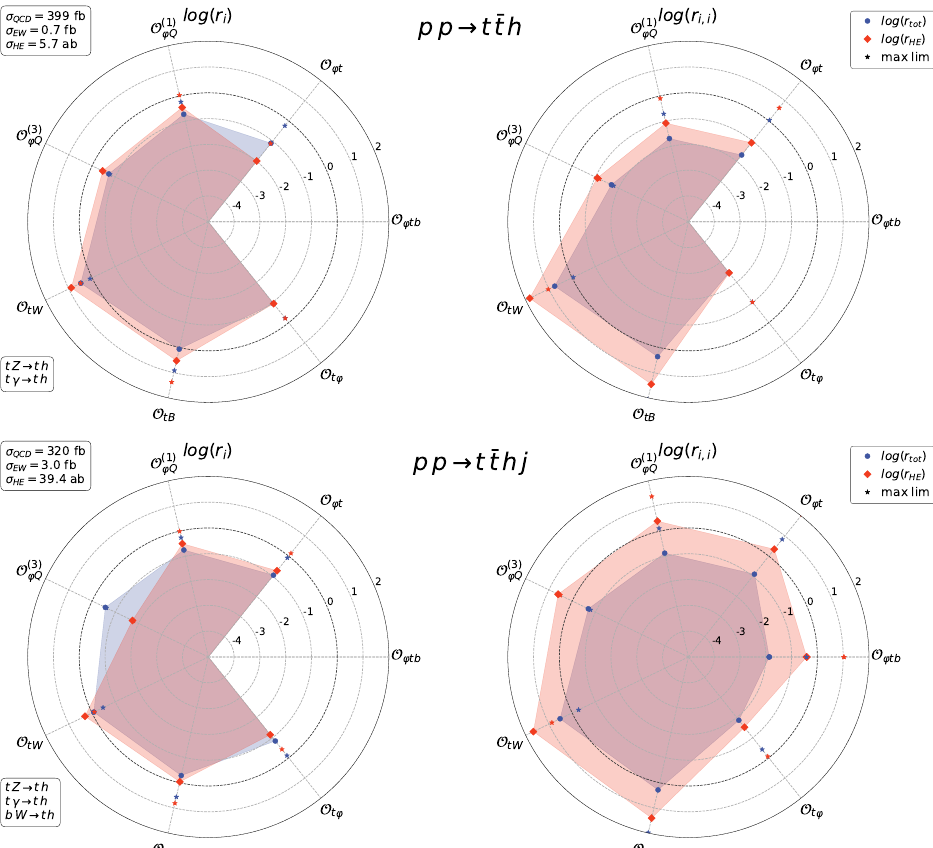
Figure 35. Radar plot for the p p LHC, see (cid:12)gure 7 and section 4.1.2 of the main text for a detailed description. The b (cid:22) b -initiated component has not been